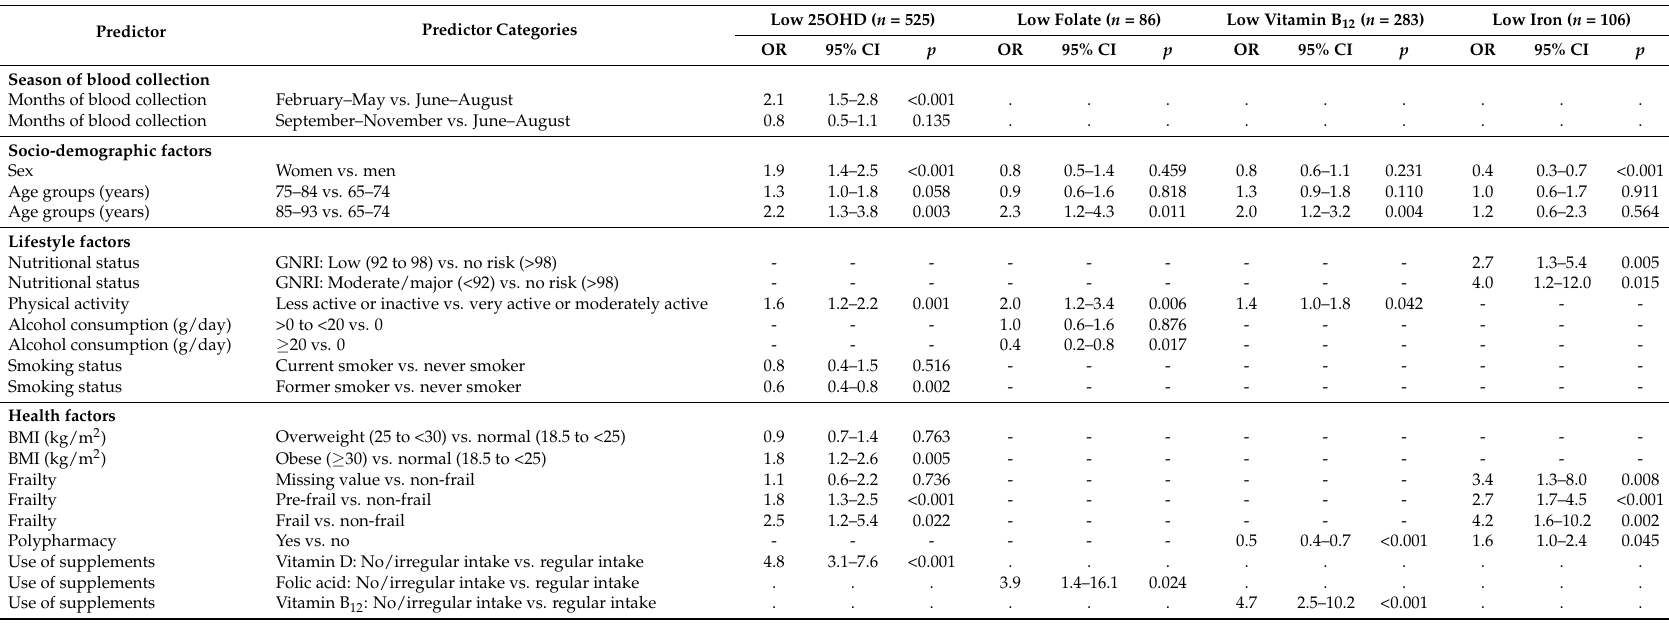
Table 3. Fully adjusted ORs with 95% CIs for subclinical micronutrient deficiencies by categories of identified predictors: Final results from multiple logistic regression analyses in KORA-Age 2008/2009.